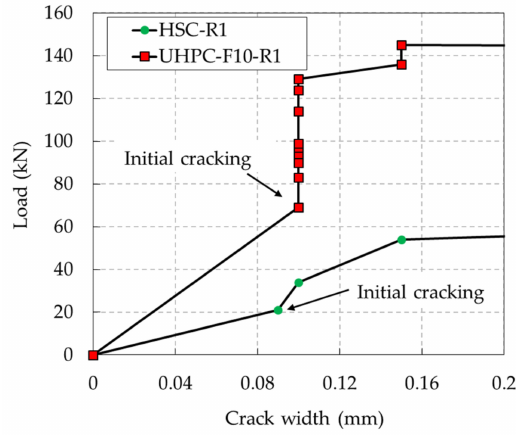
Figure 7. Comparison of the crack widths of the UHPC and HSC beams (up to a crack width of 0.2